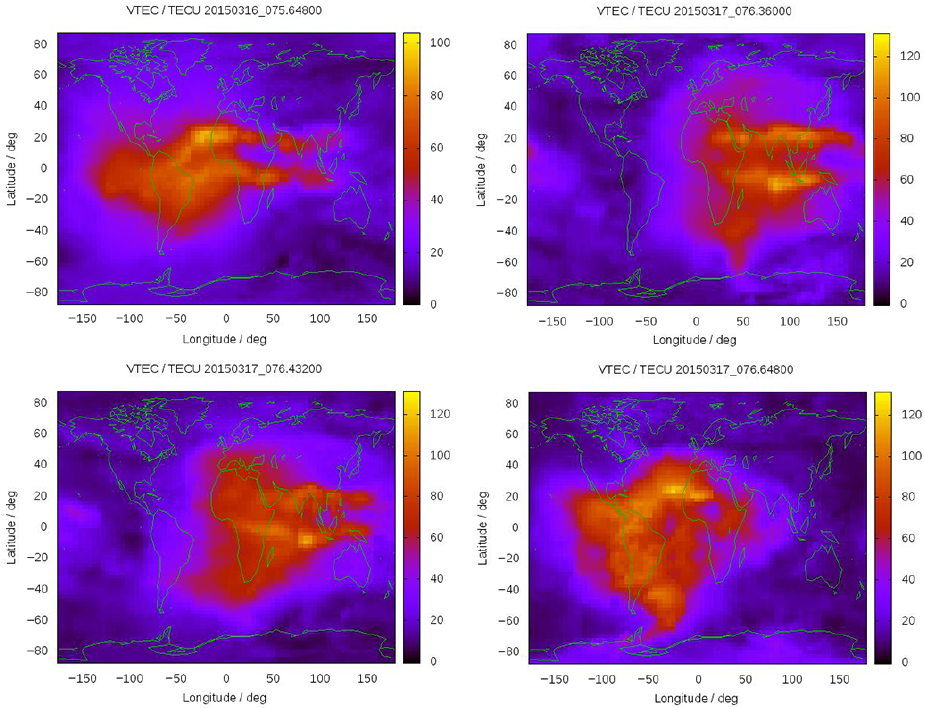
Figure 13. Rapid 15min resolution VTEC GIMs (labelled UQRG) computed by UPC’s TOMION for (from left to right, from top to bottom) 16 March at 18:00UT and 17 March at 10:00, 12:00 and 18:00UT.